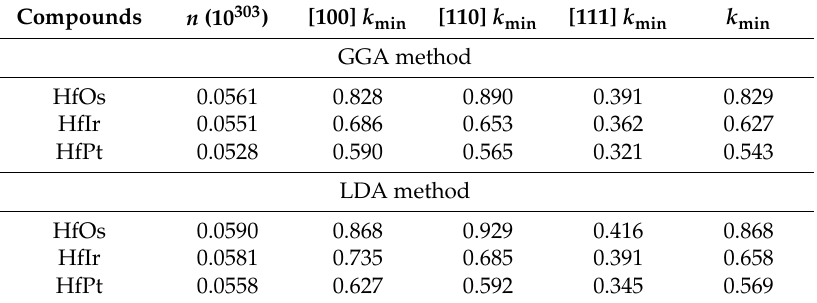
Table 7. Calculated minimum thermal conductivities k min (W/m/K) for HfX (X = Os, Ir and Pt). Compounds n (10 303